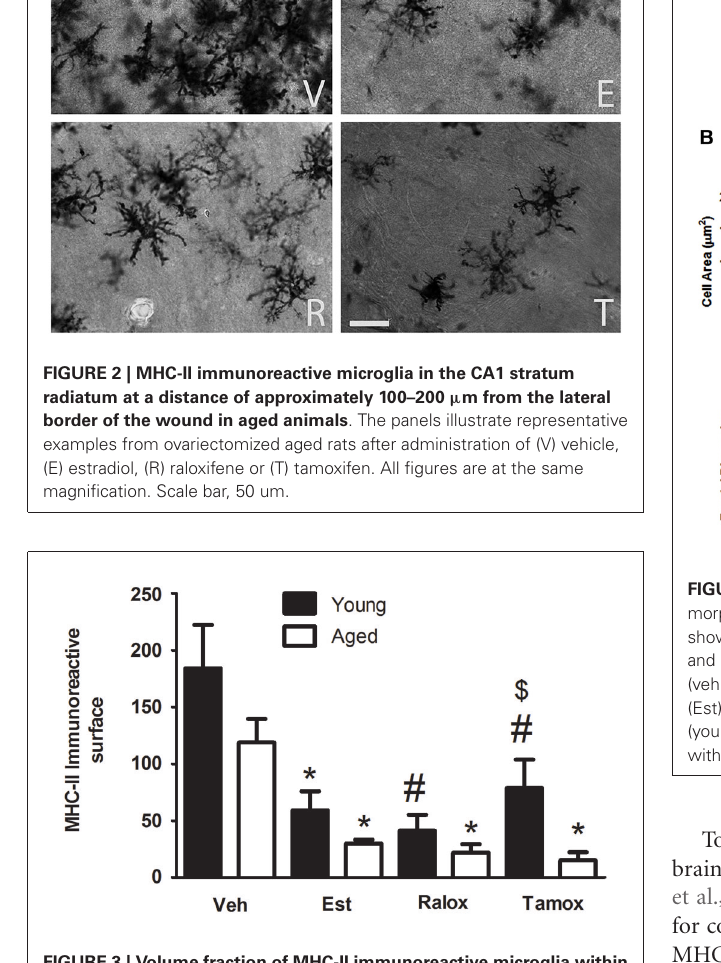
treated with estradiol ( P = 0.03), raloxifene ( P = 0.02) or tamox-